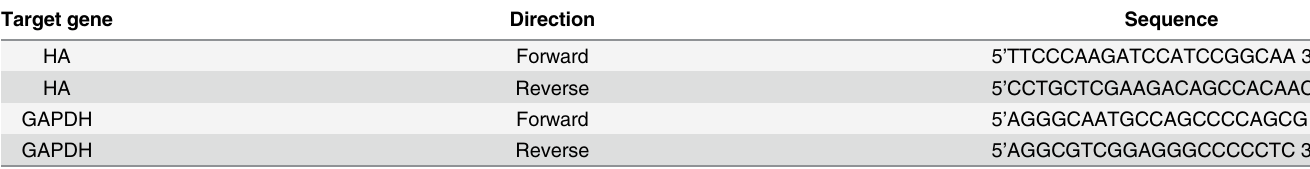
Table 2. Primer sequences for quantitative